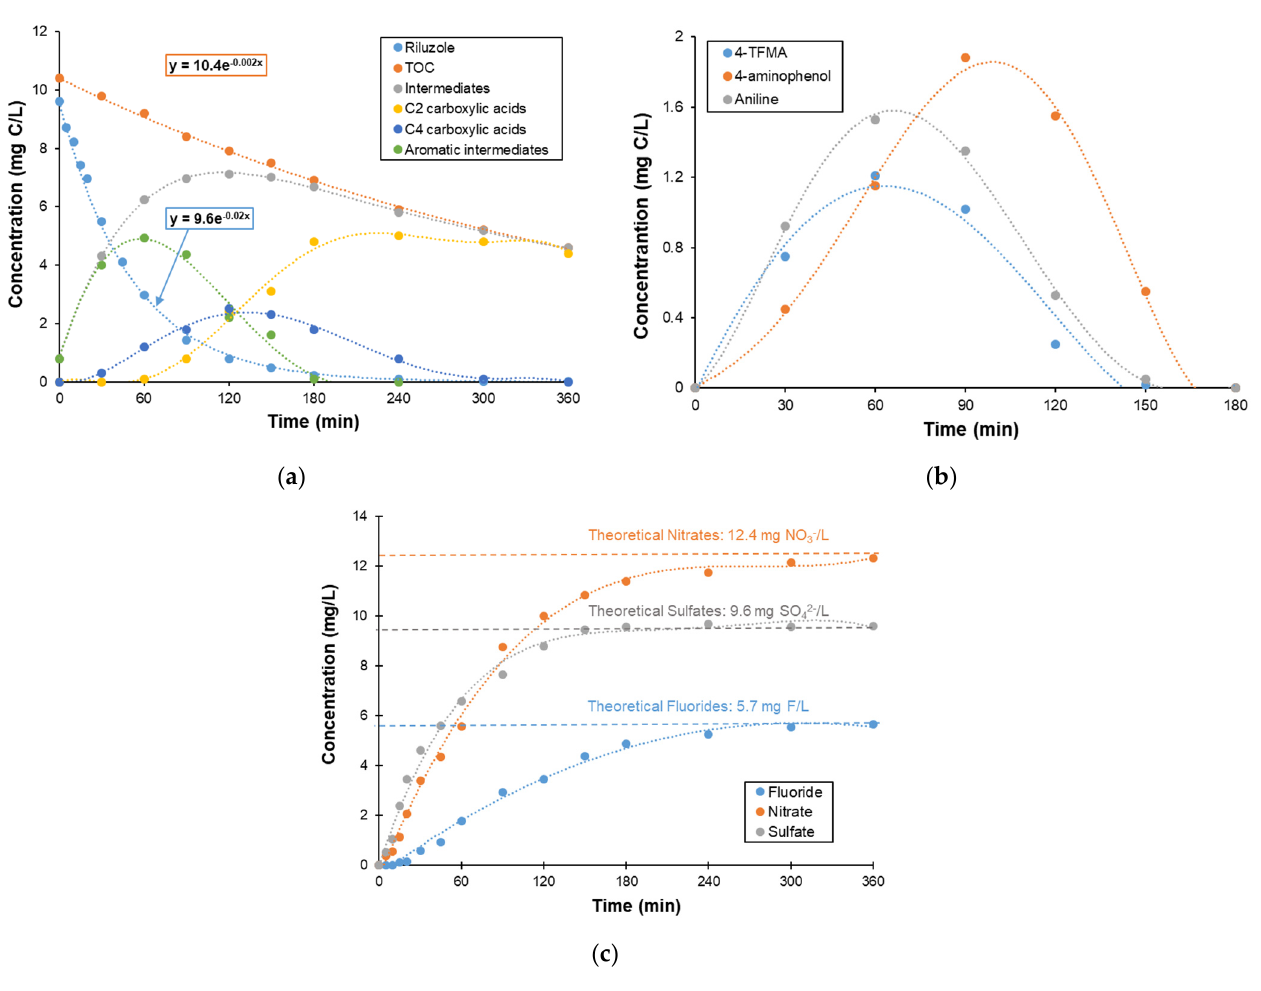
Figure 8. Changes of the concentrations of ( a , b ) organic intermediates, and ( c ) inorganic ions during the treatment of 23.4 mg/L riluzole aqueous solutions by homogeneous and heterogeneous Fenton and photo-assisted Fenton systems. Experimental conditions: H 2 O 2 : 1000 mg/L, Fe-based catalyst: 200 mg/L (particle size < 200 µm), pH = 3.0, Temperature: 23–25 °C, Mixing rate: 400 rpm.